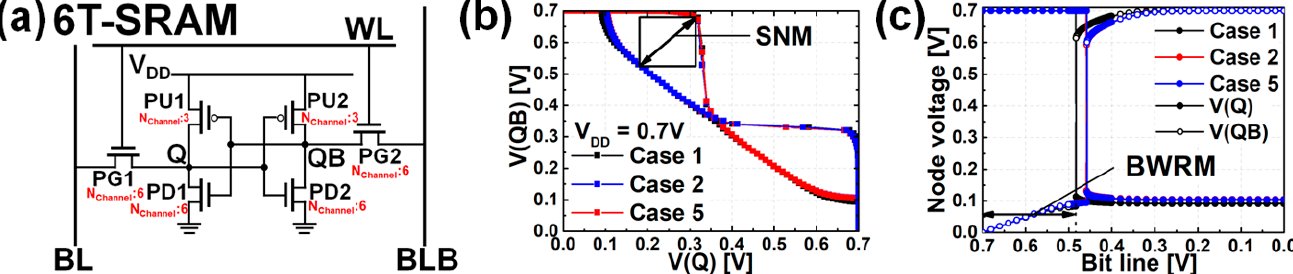
Figure 11. ( a ) 6T-SRAM schematic, ( b ) SNM results when the V DD is 0.7 V, ( c ) BWRM results when the V DD is 0.7 V. Table 3. Performance comparison of mNS-FET 6T-SRAMs. w/o BO